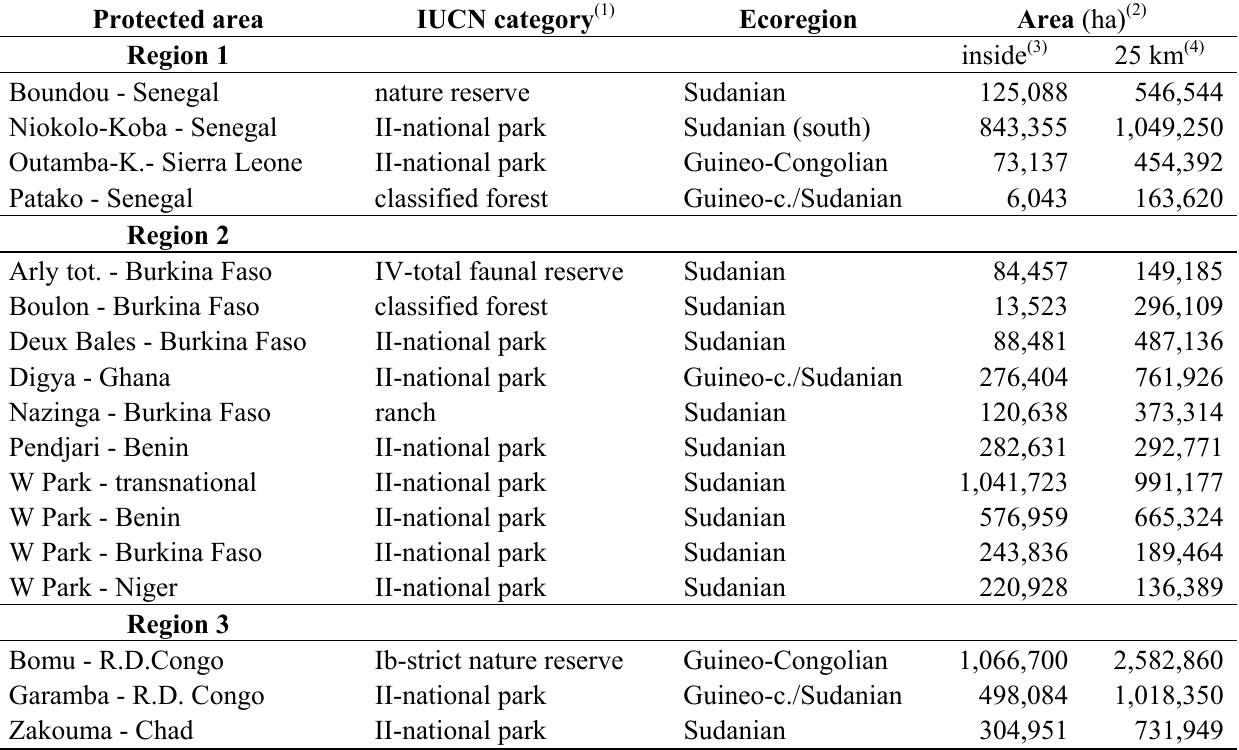
Table 1. Protected areas considered in the